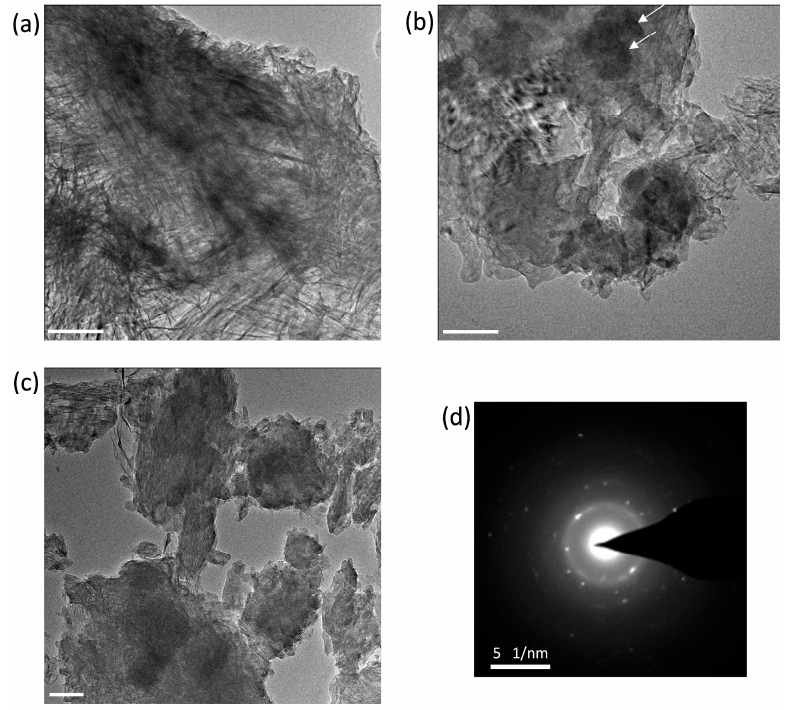
Figure 15. TEM image of C–S–H in C-FA-28d paste. ( a ) Fine OP C–S–H; ( b , c ) coarse C–S–H; and ( d ) SAED image pattern of Ca(OH) 2 in ( c ). The scale bars in ( a – c ) represent 100 nm. The large Ca(OH) 2 crystals are indicated by the arrows in ( b ). The SAED image of the sample presents a crystalline phase assumed to be nanocrystalline Ca(OH) 2 intermixed with the C–S–H phase.